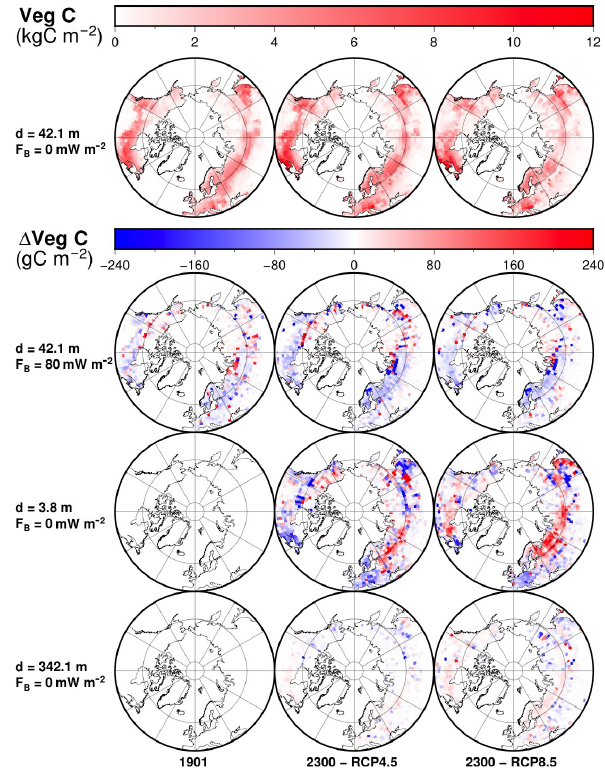
Figure 14. Distribution of soil carbon for the original model (top row) and differences to the original model at each time frame for the modified model with 80mWm − 2 (second row), the modified model with d = 3 . 8m (third row) and the modified model with d = 342 . 1m (bottom row). Time frames are shown for 1901 and 2300CE for the RCP4.5 and RCP8.5 scenarios.